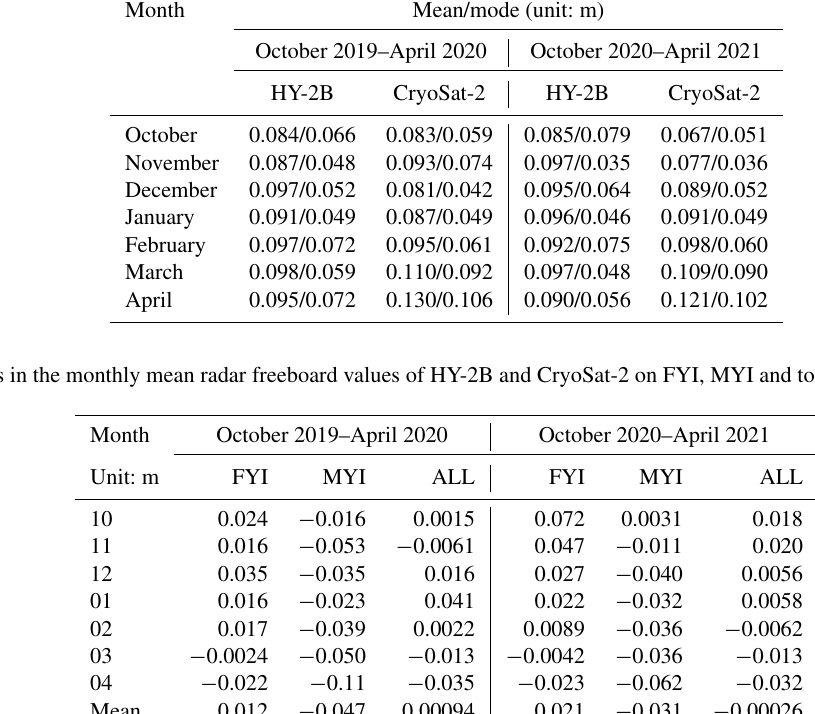
Table 3. Mean and modal radar freeboard values of HY-2B and CryoSat-2 over the common area. Month Mean/mode (unit: m)